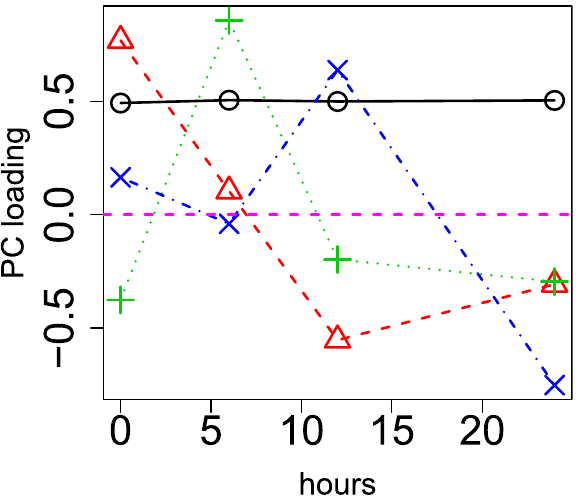
Figure 2. PC loading, v ℓ t , computed by PCA applied to time points by applying PCA to gene expression profiles. Open black circles: 1st, (0.61) open red triangles: 2nd (− 0.76), green crosses: 3rd (− 0.24), blue crosses: 4th PC loading (− 0.60). The numbers in parentheses are the Pearson’s correlation coefficients. Hours (horizontal axis) represent the duration after the treatments. The horizontal magenta broken line indicates baseline (zero).